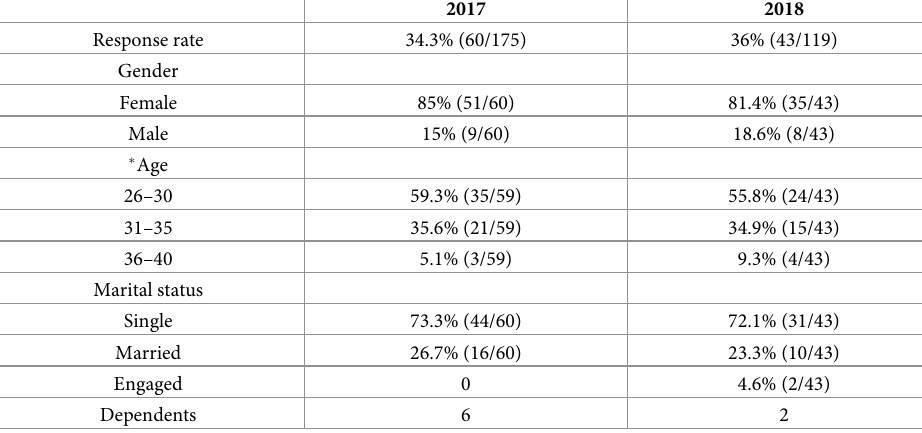
� One respondent did not indicate their age in 2017.